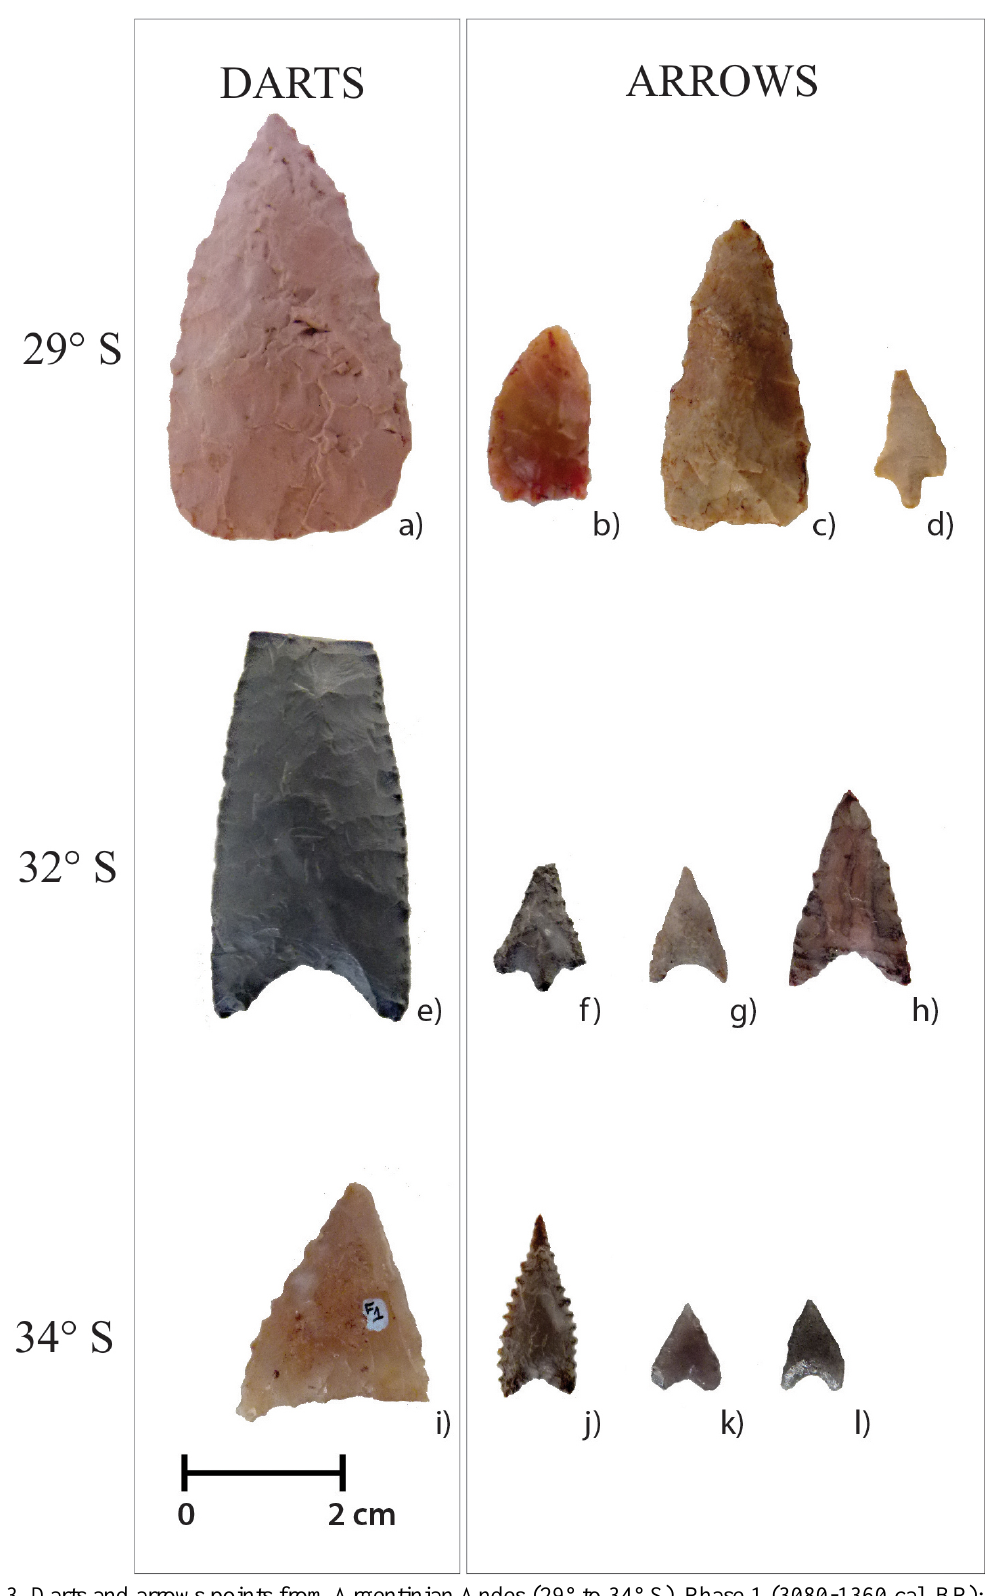
Figure 3. Darts and arrows points from Argentinian Andes (29° to 34° S). Phase 1 (3080-1360 cal. BP): a) point 4, which is similar in size and shape to those published by Gambier (1977:92-93) from 30-31° S associated with dates in the range of Phase 1; b) point 1, which has an impact fracture on the right edge (Castro 2017:9), c) point 2, e) point 7. Phase 2 (1280-550 cal. BP): f) point 11, i) point 26, j) point 28, k) point 19, l) point 22. Phase 3 (550-400 cal. BP): d) point 33, g) point 37, h) point